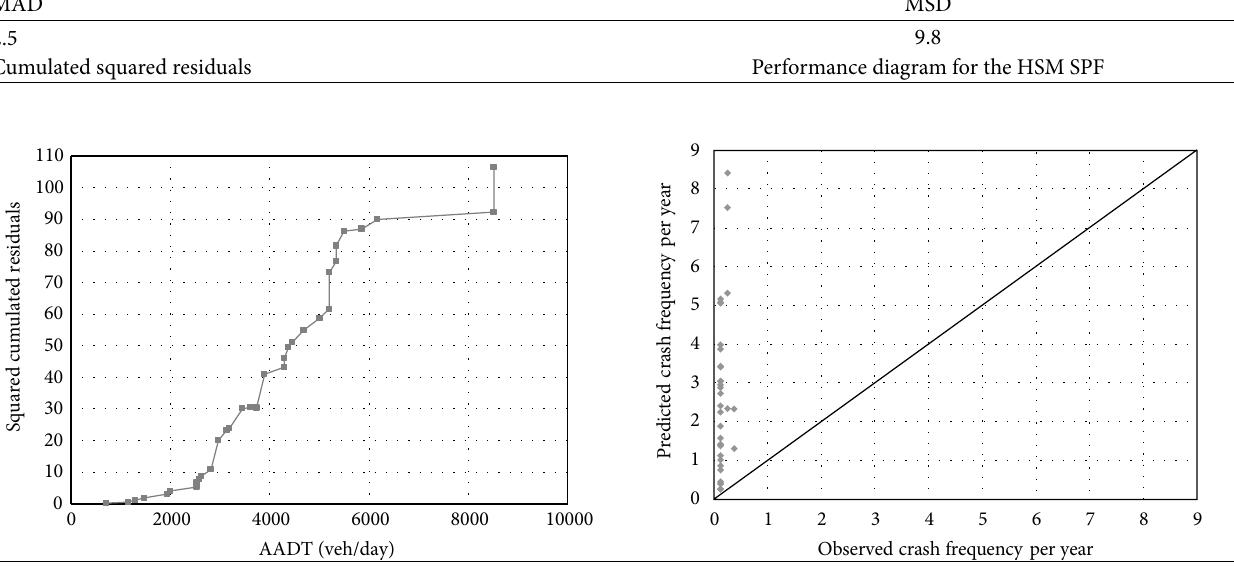
Table 3. The over-dispersion parameter for this SPF is 0.59.